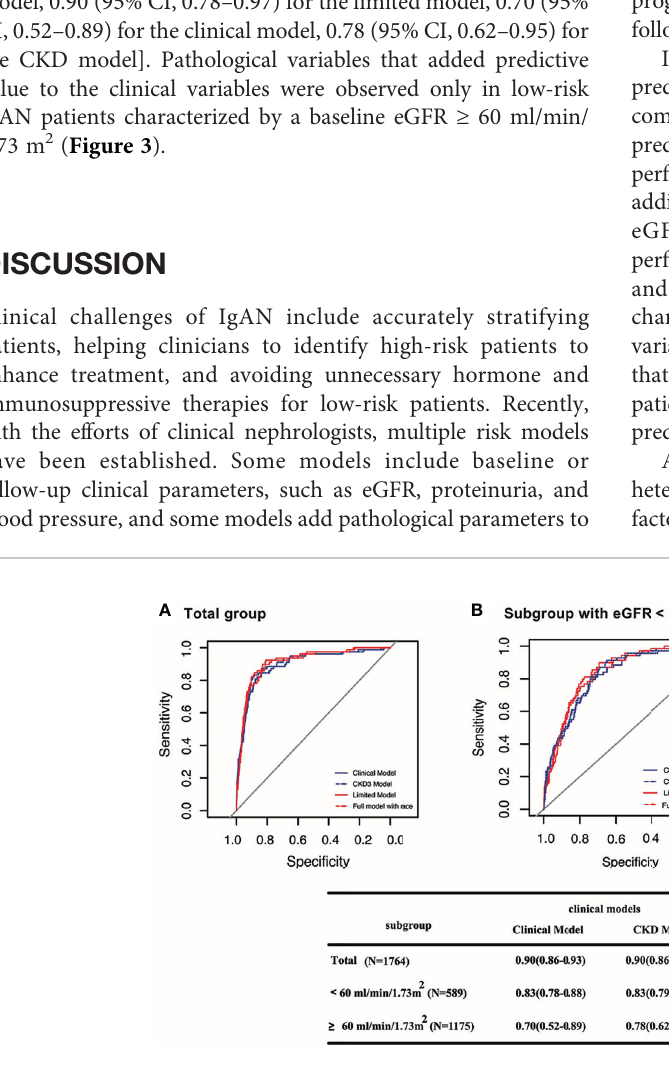
FIGURE 3 | Survival ROC curves of four models for predicting ESRD at 5 years in different subgroups. The area the under the curve (AUC) and 95% CI of the Clinical Model, CKD Model, Limited Model, and Full Model, respectively, in total patients (A) ; in patients with baseline eGFR < 60 ml/min/1.73 m 2 (B) ; in patients with baseline eGFR ≥ 60 ml/min/1.73 m 2 (C)